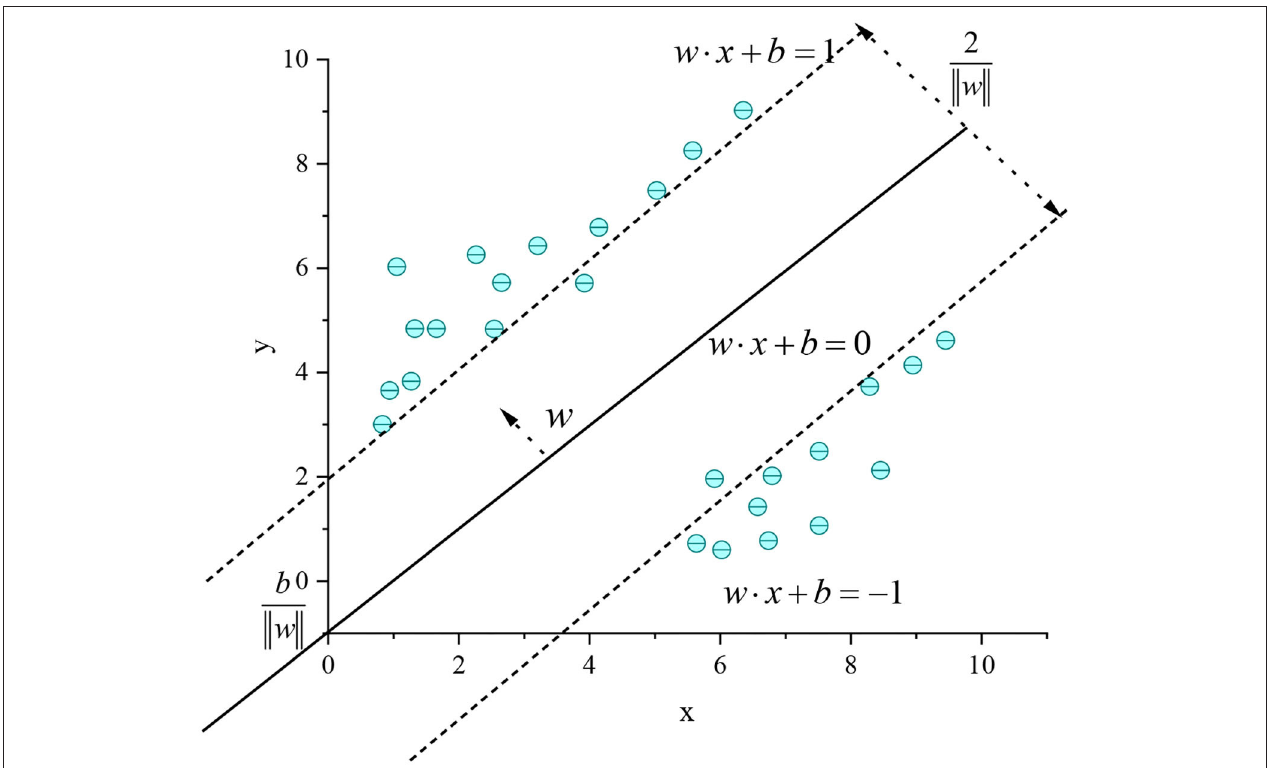
FIGURE 3 | SVM regression